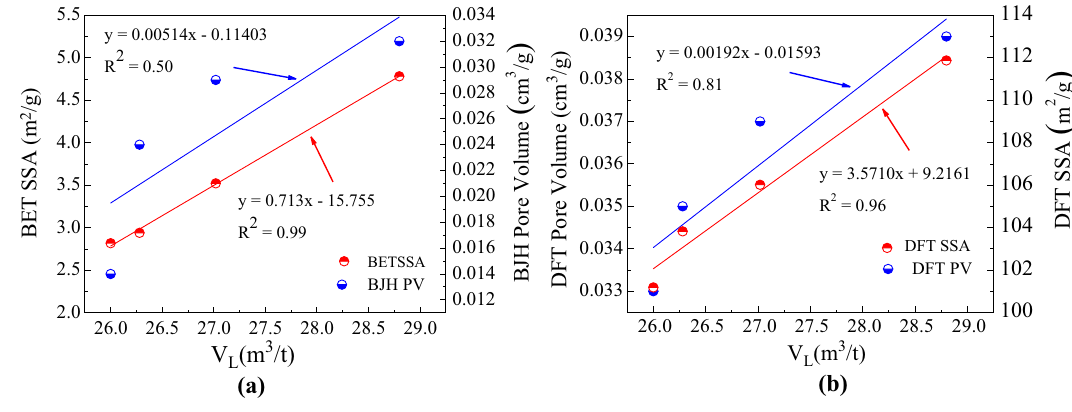
Fig. 9 a Correlation of V L with BET-SSA and BJH-PV; b Correlation of